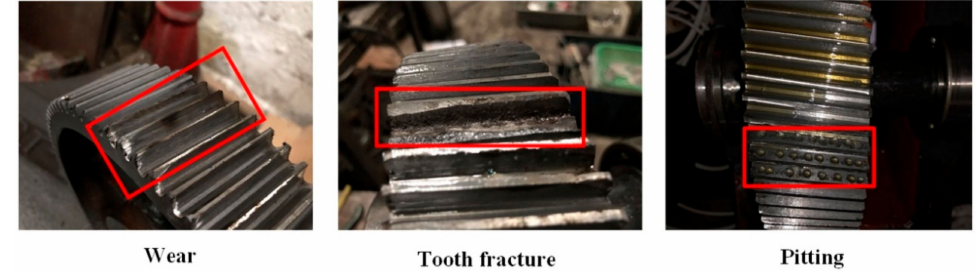
Figure 6. Fault pattern of the